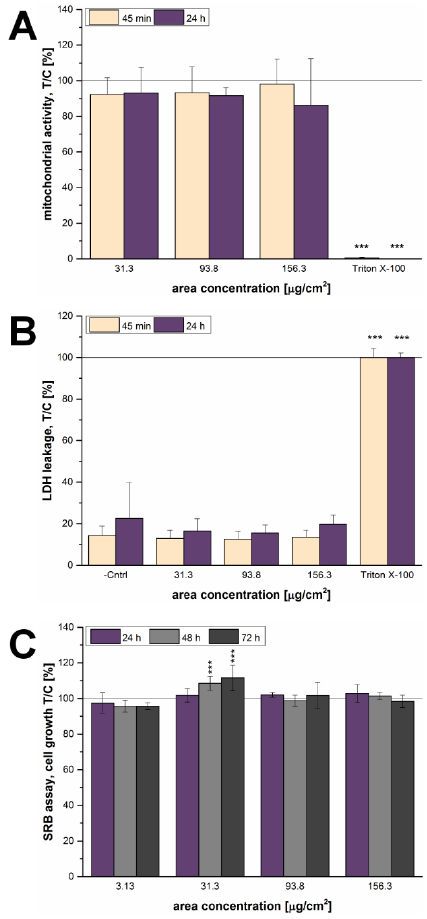
Figure 4. Analysis of the cytotoxic effects of 12 nm SiO 2 NPs on GXF251L cells. ( A ) Influences on the mitochondrial activity determined by WST-1 assay and ( B ) on the membrane integrity determined by LDH leakage assay after 45 min and 24 h of incubation; ( C ) Growth effects after 24 h, 48 h and 72 h of incubation determined by SRB assay. For WST-1 and SRB assay all effects were quantified in relation to the negative assay control (T/C [%]). For the LDH leakage assay effects were quantified in relation to the positive assay control (T/C [%]). The solid lines represent the respective control set to 100%. Triton X-100 (1% v / v ) was used as positive control. Statistical analysis was performed by One-way ANOVA followed by Fisher’s LSD test. Significances indicated as * refer to a comparison to the respective negative control (* ≡ p ≤ 0.05; ** ≡ p ≤ 0.01 and *** ≡ p ≤ 0.001; n ≥